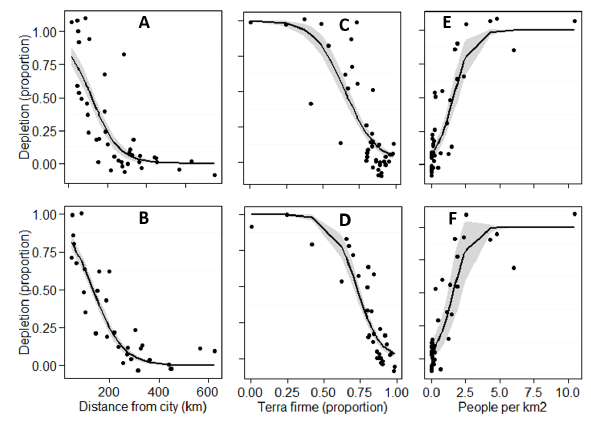
Fig. 5 . Model predictions (solid lines, with standard errors in gray) and field estimates (solid dots) for the depletion (absence) of hunted vertebrates within census sectors (n = 41) in Amazonas State, Brazil, for three predictors: (A-B) travel distance from nearest urban center; (C-D) coverage of upland terra firme; and (E-F) human population density. Species are: tapir, Tapirus terrestris (A,F); woolly monkeys, Lagothrix spp. (B,D); white-lipped peccary, Tayassu pecari (C,E). Minimal generalized linear model (GLM) results for proportional